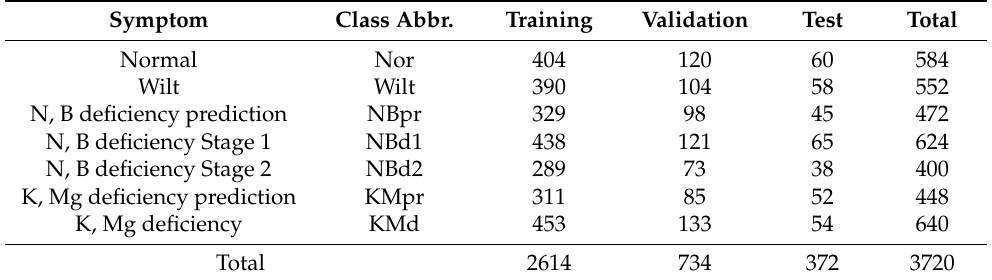
Table 1. Number of samples in the training, validation, and test categories for physiological